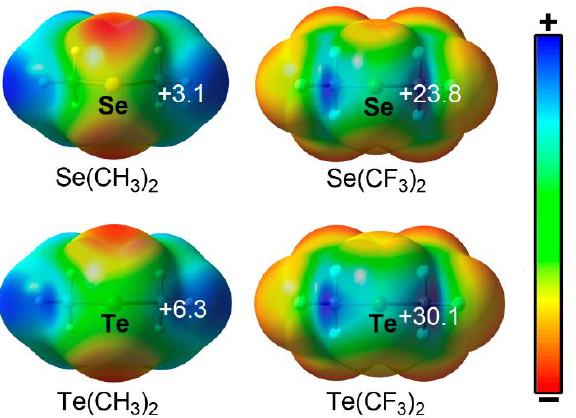
Figure 1. MEP surfaces (MP2 [66]/def2-TZVP [67] level of theory) of the Ch(CH 3 ) 2 and Ch(CF 3 ) 2 (Ch = Se and Te) molecules. The energy values at concrete points of the surface are given in kcal/mol (0.001 a.u.). The calculations have been performed by means of the Turbomole 7.0 software (Karlsruhe, Germany) [68].